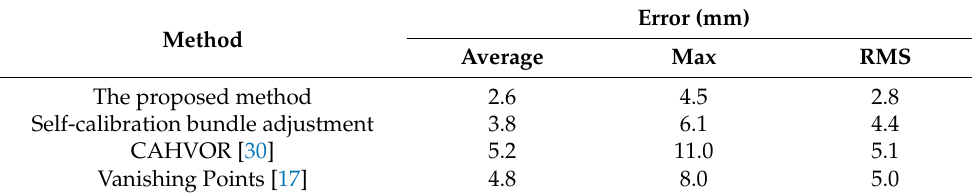
Table 5. Errors of the 64 checkpoints.